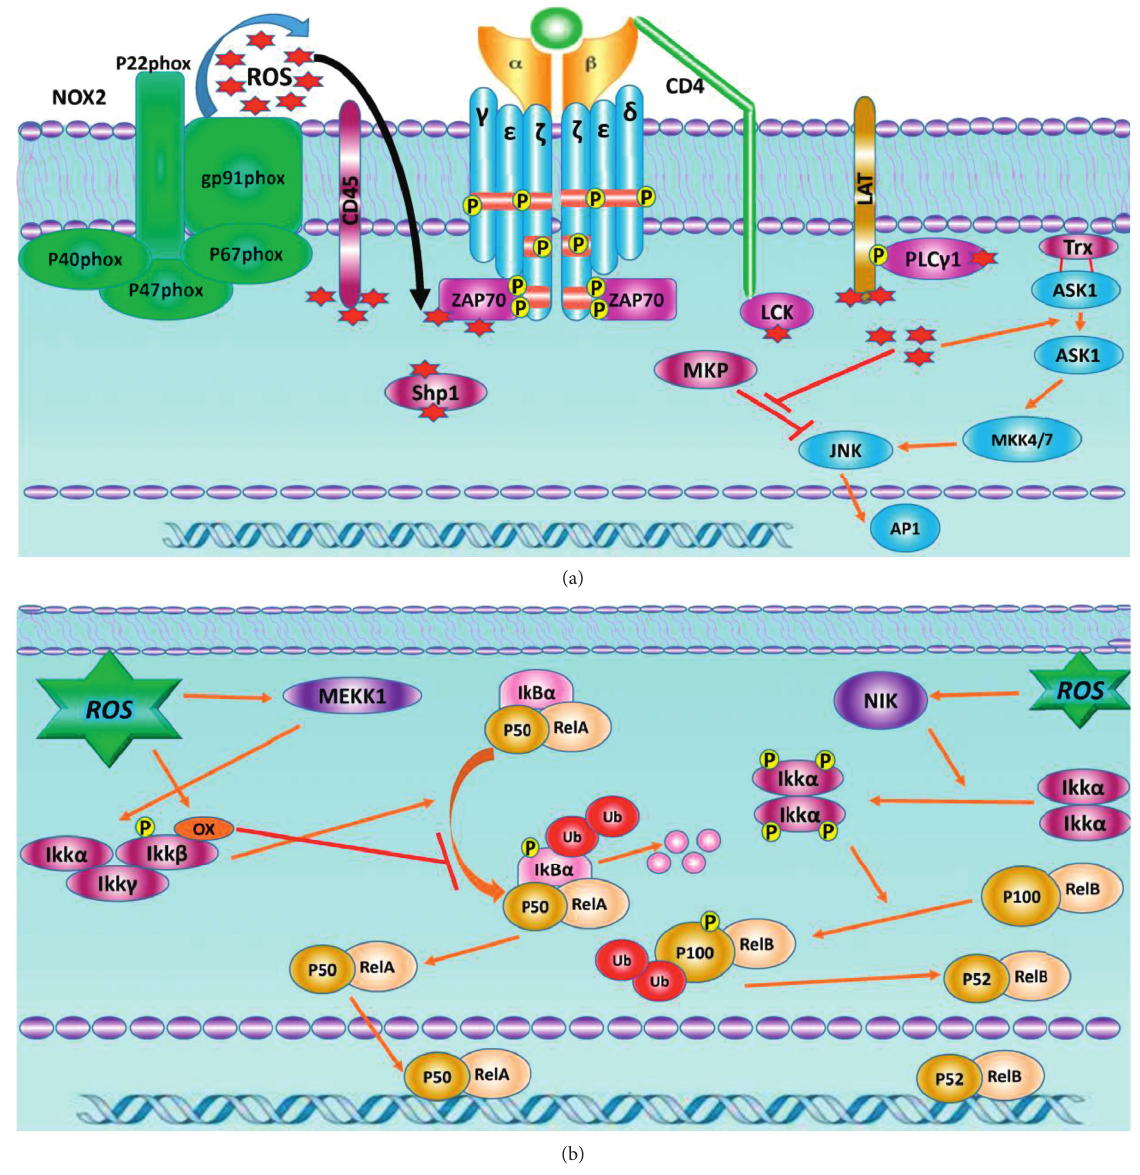
Figure 2: ROS effects on TCR signaling. TCR engagement leads to ROS production (red stars) from NOX2 at the plasma membrane. (a) Possible targets of ROS including LAT, ZAP70, SHP-1, Lck, and CD45. (b) Crosstalk of ROS with NF- κ B signaling pathways. TCR, T-cell receptor; NOX2, NADPH oxidase 2; ROS, Reactive oxygen species; LAT, linker for activation of T cell; ZAP70, Zeta Chain Of T-Cell Receptor Associated Protein Kinase 70; SHP-1, Src homology 2 domain-containing protein tyrosine phosphatase 1; Lck, lymphocyte- specific protein tyrosine kinase; MEKK1, mitogen-activated protein kinase kinase kinase 1; NIK, NF- κ B inducing